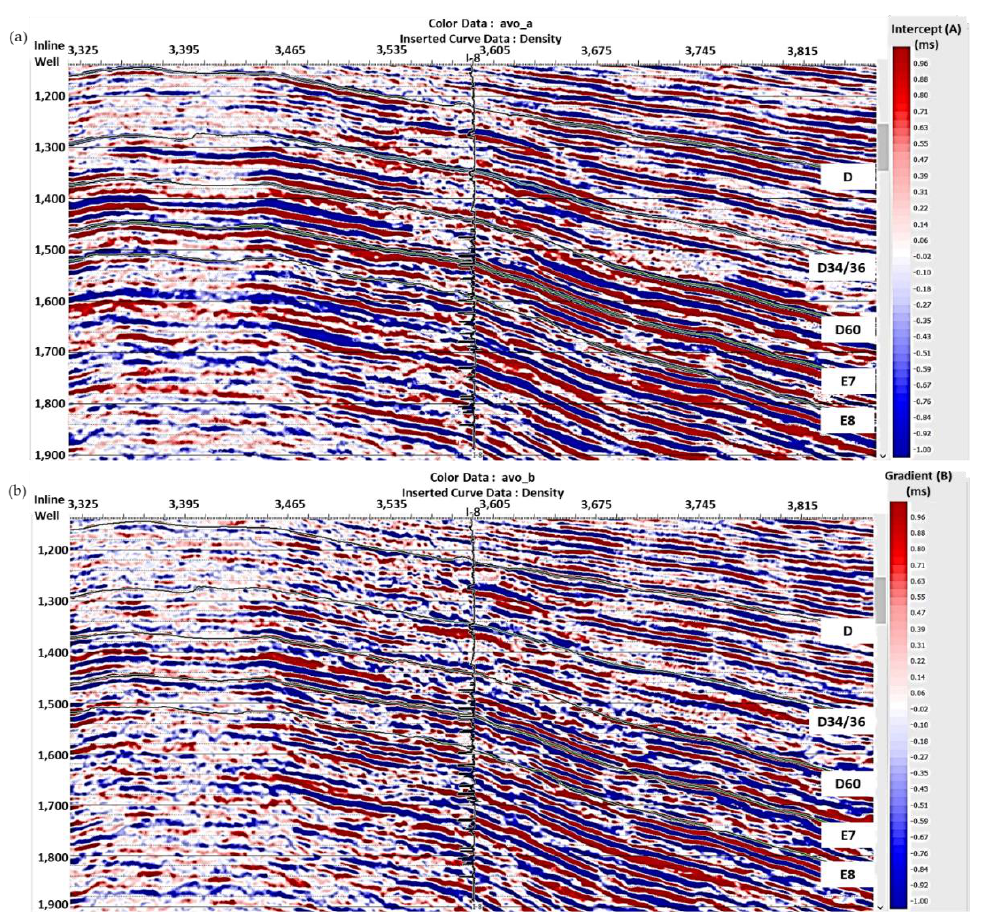
Figure 6. Xline 5078 intersection for ( a ) Intercept, ( b ) gradient.